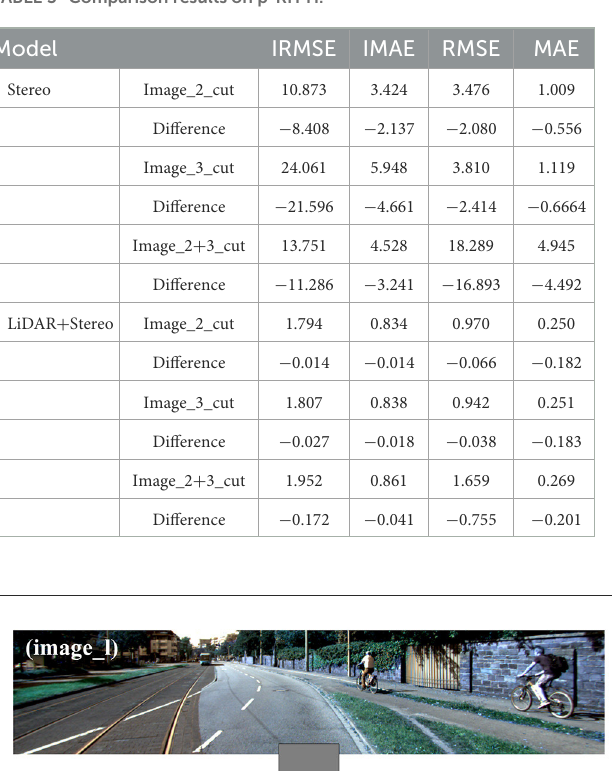
TABLE 3 Comparison results on p-KITTI.